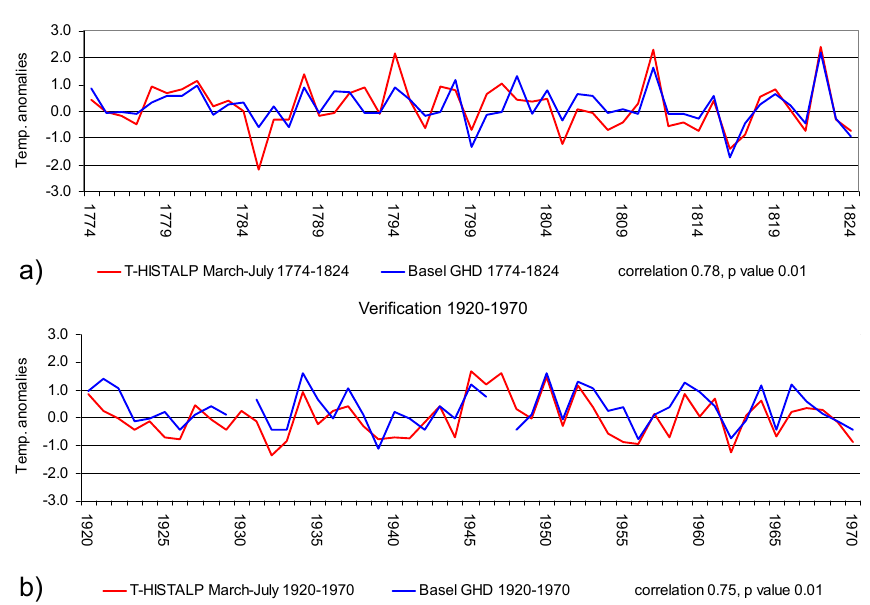
Fig. 7. (a) Calibration (1774–1824) and (b) Verification (1920–1970) of Basel WGHD series with HISTALP temperature anomalies (mean March-July temperatures); Standard Error of Estimate = 0.6 ◦ C.